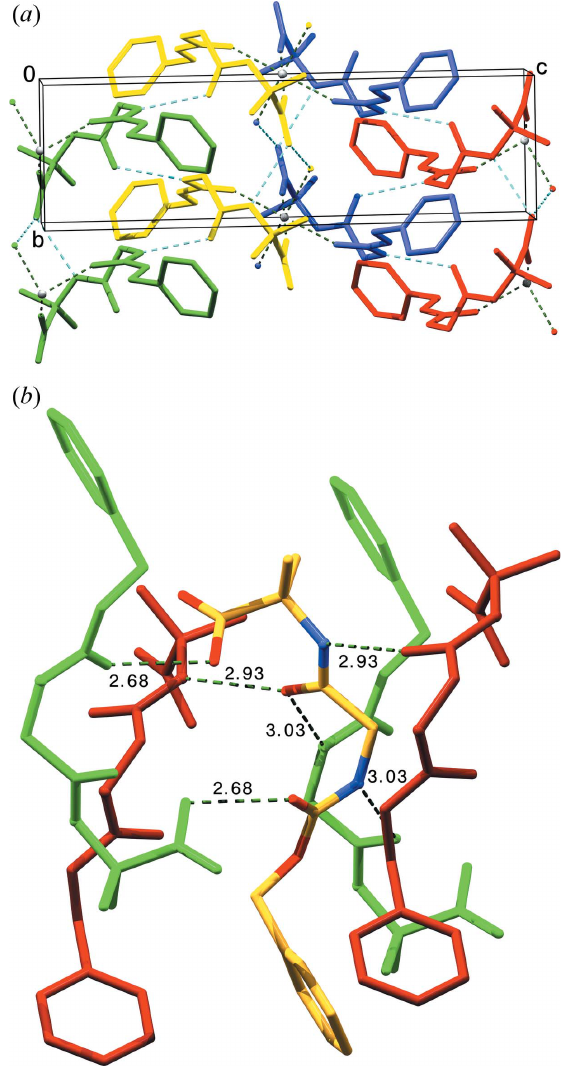
Figure 3 Molecular packing of I and II showing the bonding to neighbouring molecules. ( a ) In I , the Ca 2+ ions are shown as a grey spheres at the inversion centres of the unit cell while the other spheres signify water molecules. The content of two y -translated unit cells is shown. Hydrogen bonds are shown in cyan and the metal coordination bonds are shown in dark green. ( b ) The bonding of the central molecule II (coloured atoms) to four neighbouring molecules via hydrogen